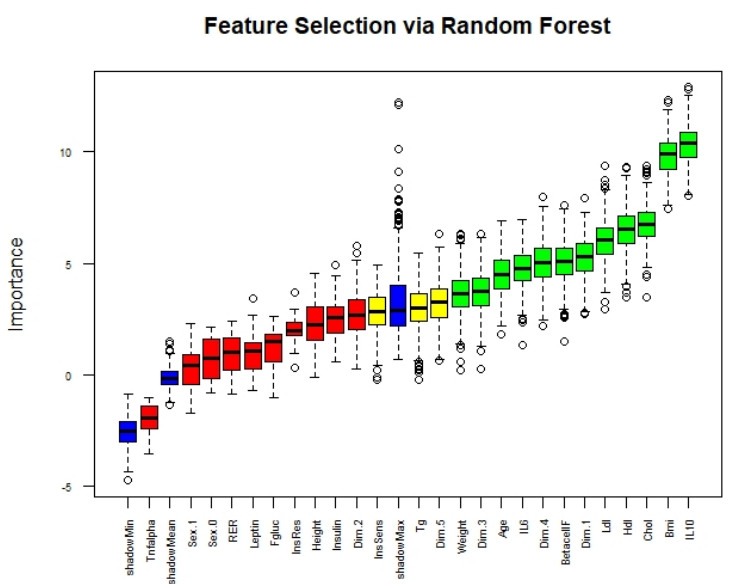
Figure 3. Recursive feature elimination; in green are depicted the variables that are certain. IL6. = Interleukin-6, IL-10 = Interleukin-6, RER = Respiratory Exchange Ratio, Sex.0 = females, Sex.1 = males, Dim.1 = Dimension 1 of the PCA, Dim.2 = Dimension 2 of the PCA Dim.3 = Dimension 3 of the PCA, Dim.4 = Dimension 4 of the PCA, Dim.5 = Dimension 5 of the PCA.